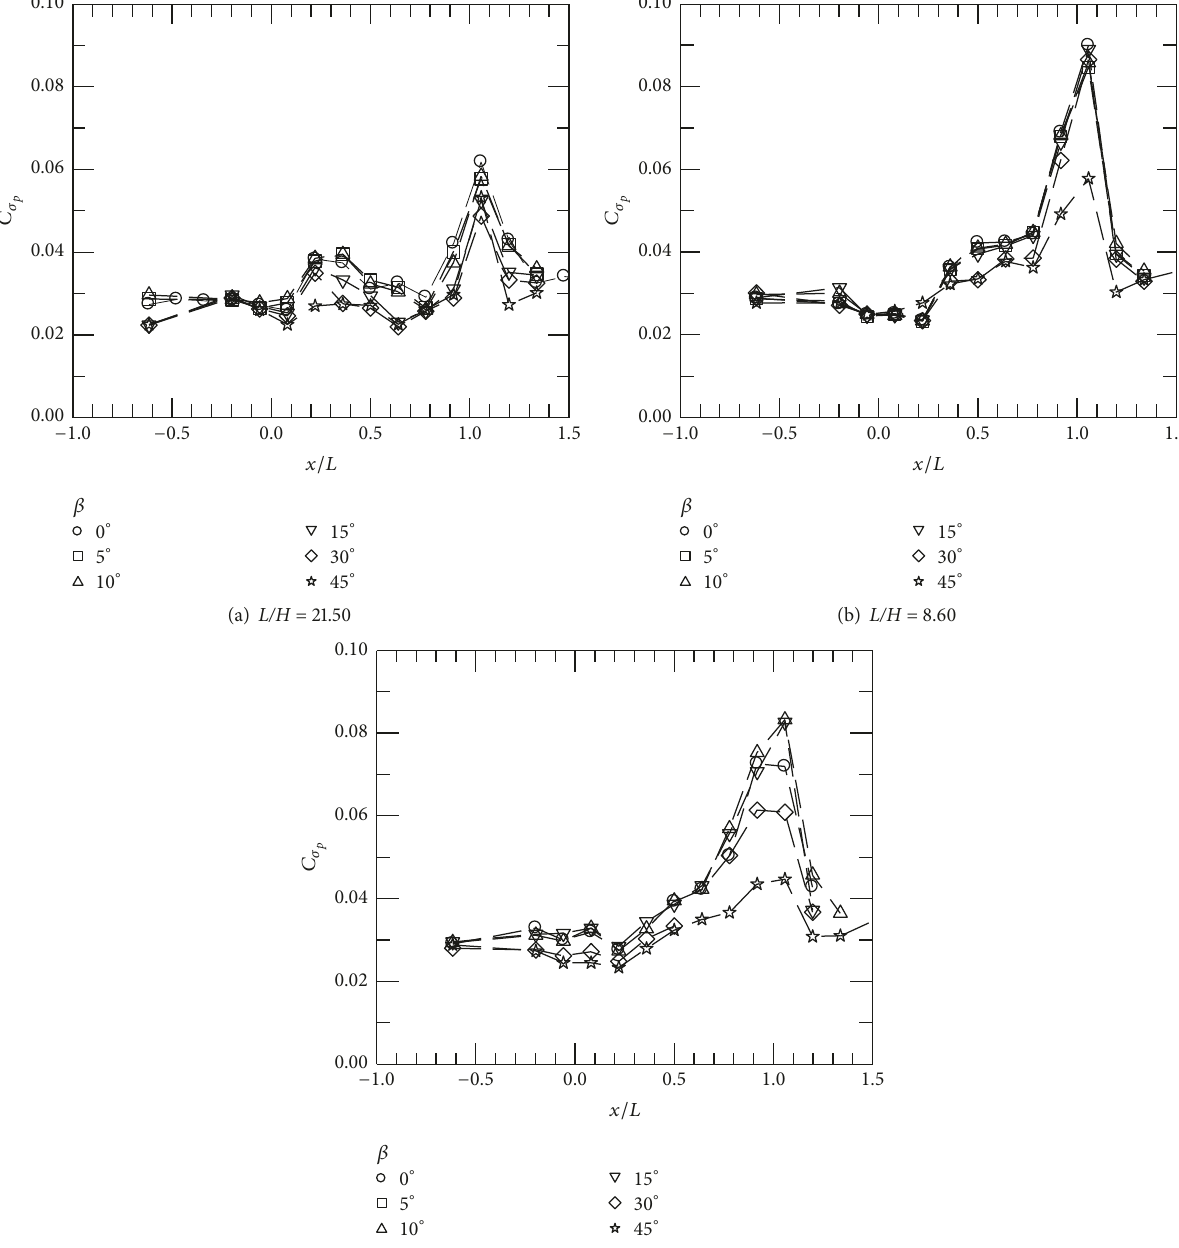
2nd mode is less apparent. Taking the effect of the yaw angle into account, the frequency of the 1st mode for L/H = 4.43 and for 𝛽 = 10 ∘ and 15 ∘ , as shown in Figure 11(a), is slightly greater than that for 𝛽 = 0 ∘ and the values for the SPL decrease as the value of 𝛽 increases. For the 2nd and 3rd modes, an increase in the value of 𝛽 results in a reduction in their frequencies and their amplitudes. Only the 1st mode is evident for 𝛽 = 30 ∘ and self-sustained oscillations are only just evident for 𝛽 = 45 ∘ . Figure 11(b) shows that, for L/H = 6.14, there